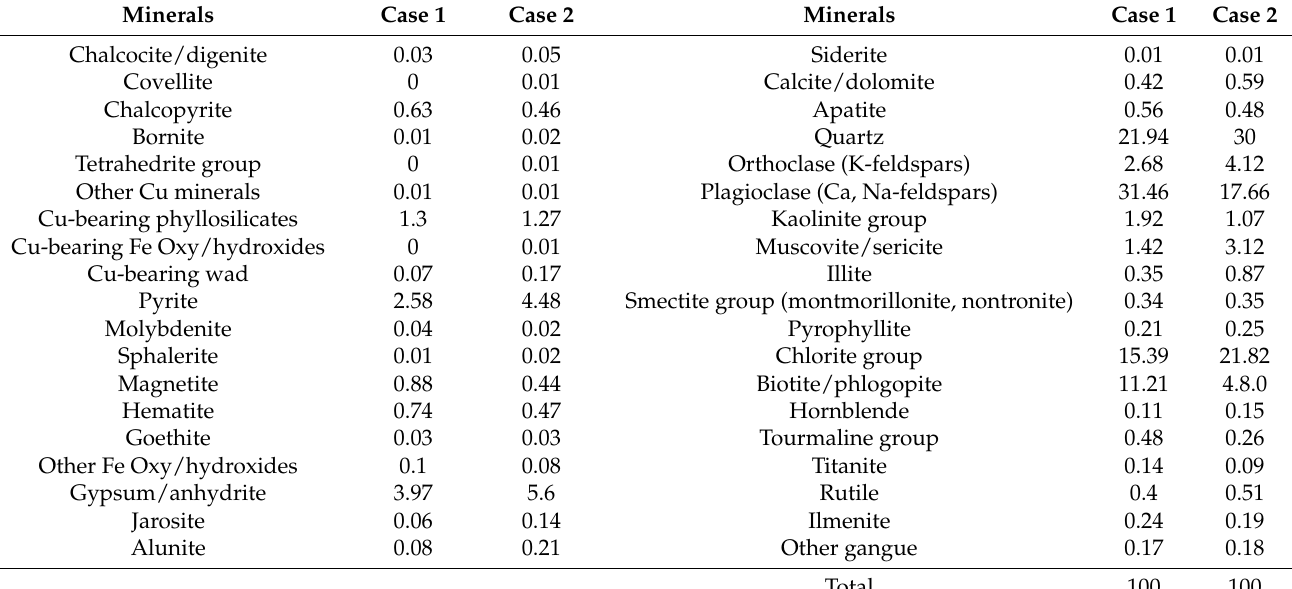
Table 4. QEMSCAN analysis for Case 1 and Case 2 samples in wt%.